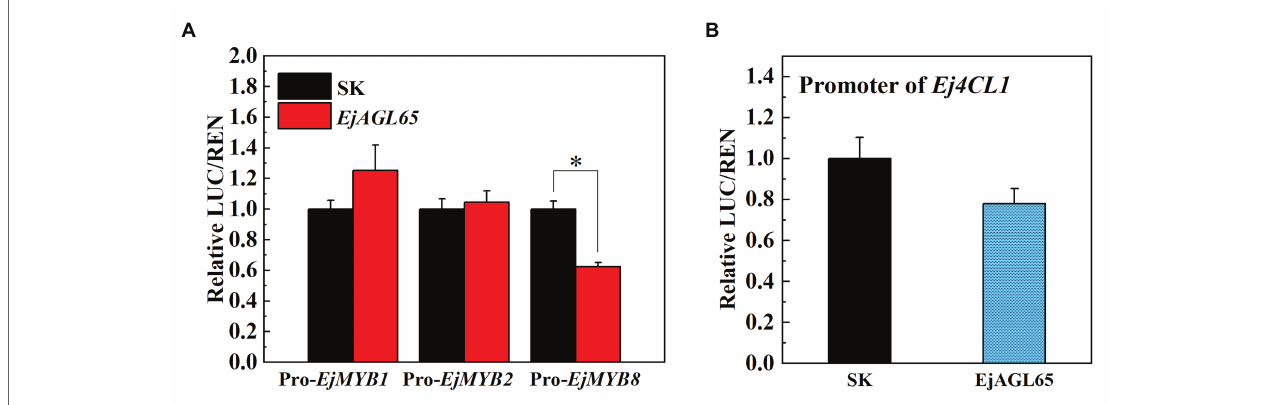
FIGURE 4 | Luciferase assay between EjAGL65 and lignin biosynthesis-related genes. The SK vector contains the coding sequence of EjAGL65; the LUC vectors with the insertion of the EjMYB1 , EjMYB2 , EjMYB8 (A) , and Ej4CL1 (B) promoter were pairwise transformed into the Agrobacterium strain GV1301 followed by leaf infection. The LUC/REN value represents the activation (above 1) or inhibition (below 1) effect generated by EjAGL65. A combination of the Empty SK vector and LUC vectors with different promoters was used as a calibration (set as 1). Error bars represent five replicates. The asterisk indicates a significant difference according to the Student’s t -test at a significance level of 0.05 ( * p <